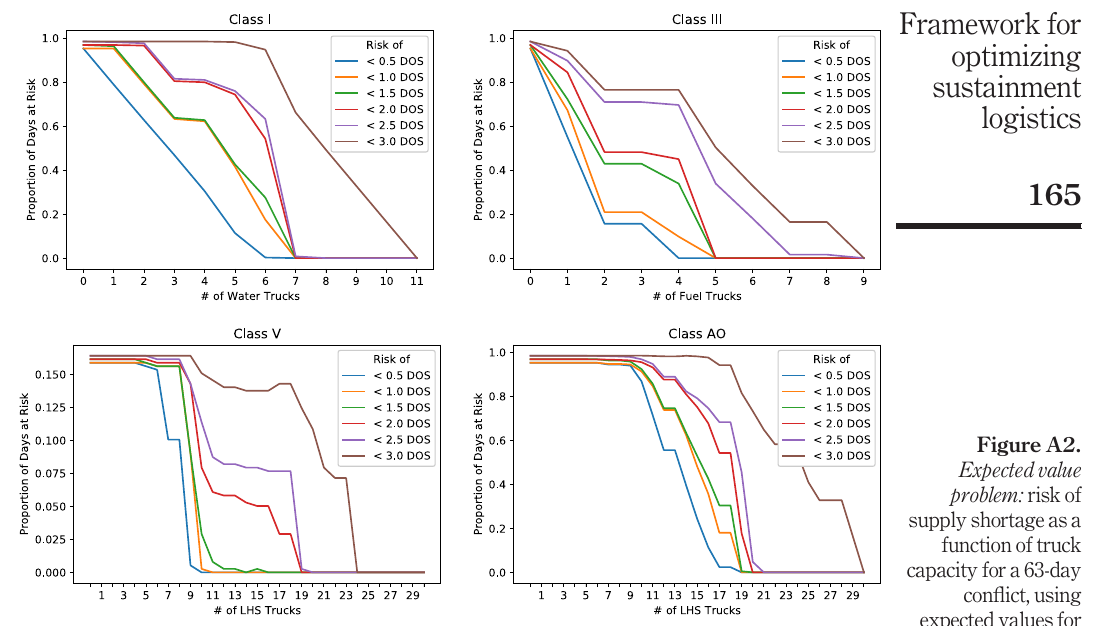
Figure A2. Expected value problem: risk of supply shortage as a function of truck capacity for a 63-day con fl ict, using expected values for truck availability